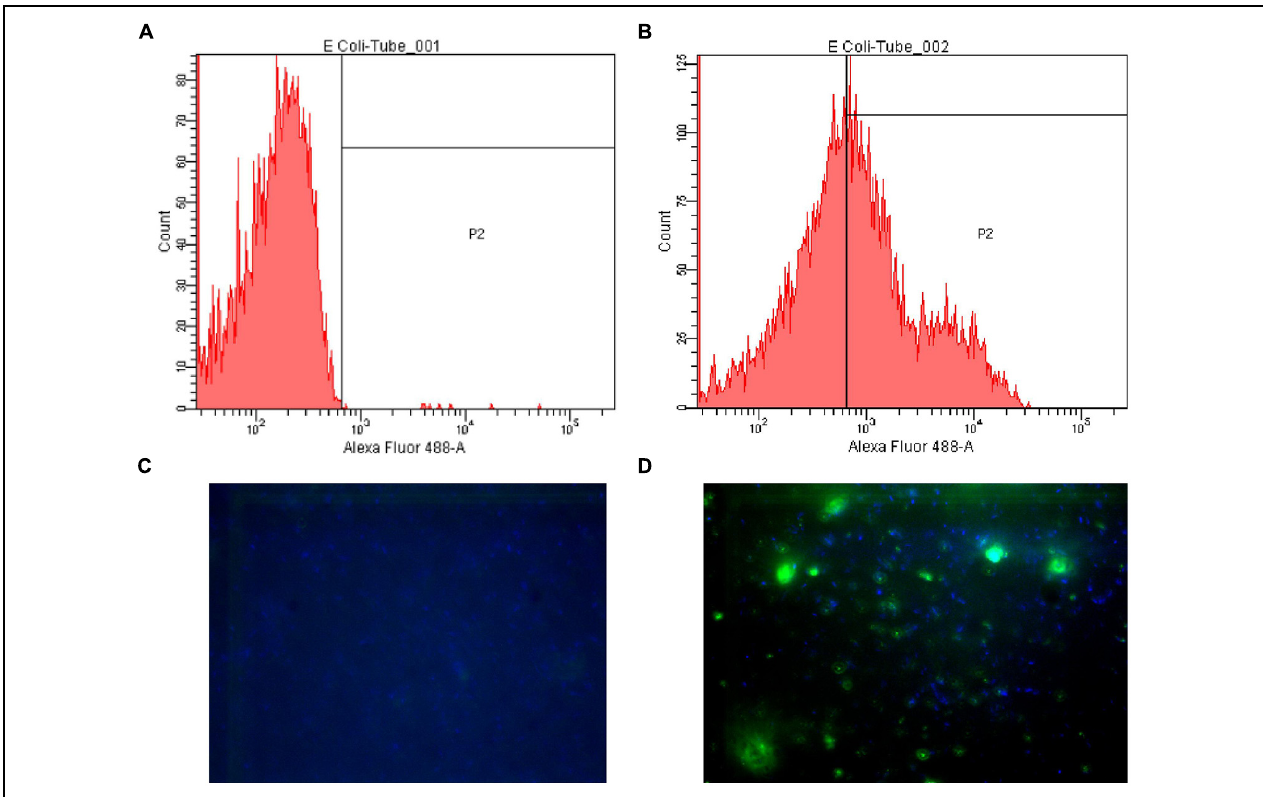
FIGURE 1 | Examples of flow cytometry and fluorescence microscopy results. (A) Flow cytometry plot of Escherichia coli LMG8223 stained by an irrelevant IgG3 (negative control); (B) Flow cytometry plot of E. coli LMG8223